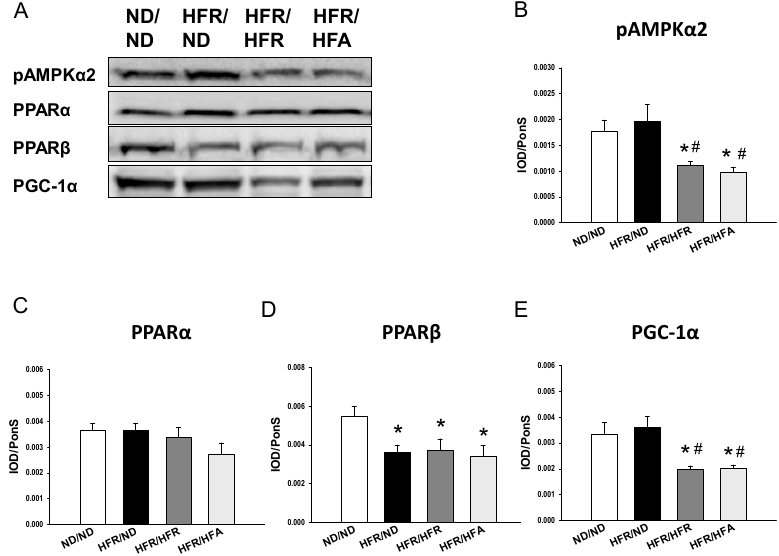
Figure 3. ( A ) Representative Western blots and relative abundance of ( B ) phosphor-AMPK α 2 (63 kDa); ( C ) PPAR α (52 kDa); ( D ) PPAR β (52 kDa); and ( E ) PGC-1 α (90 kDa) in offspring kidneys at 12 weeks of age. n = 8/group. * p < 0.05 versus ND/ND; # p < 0.05 versus